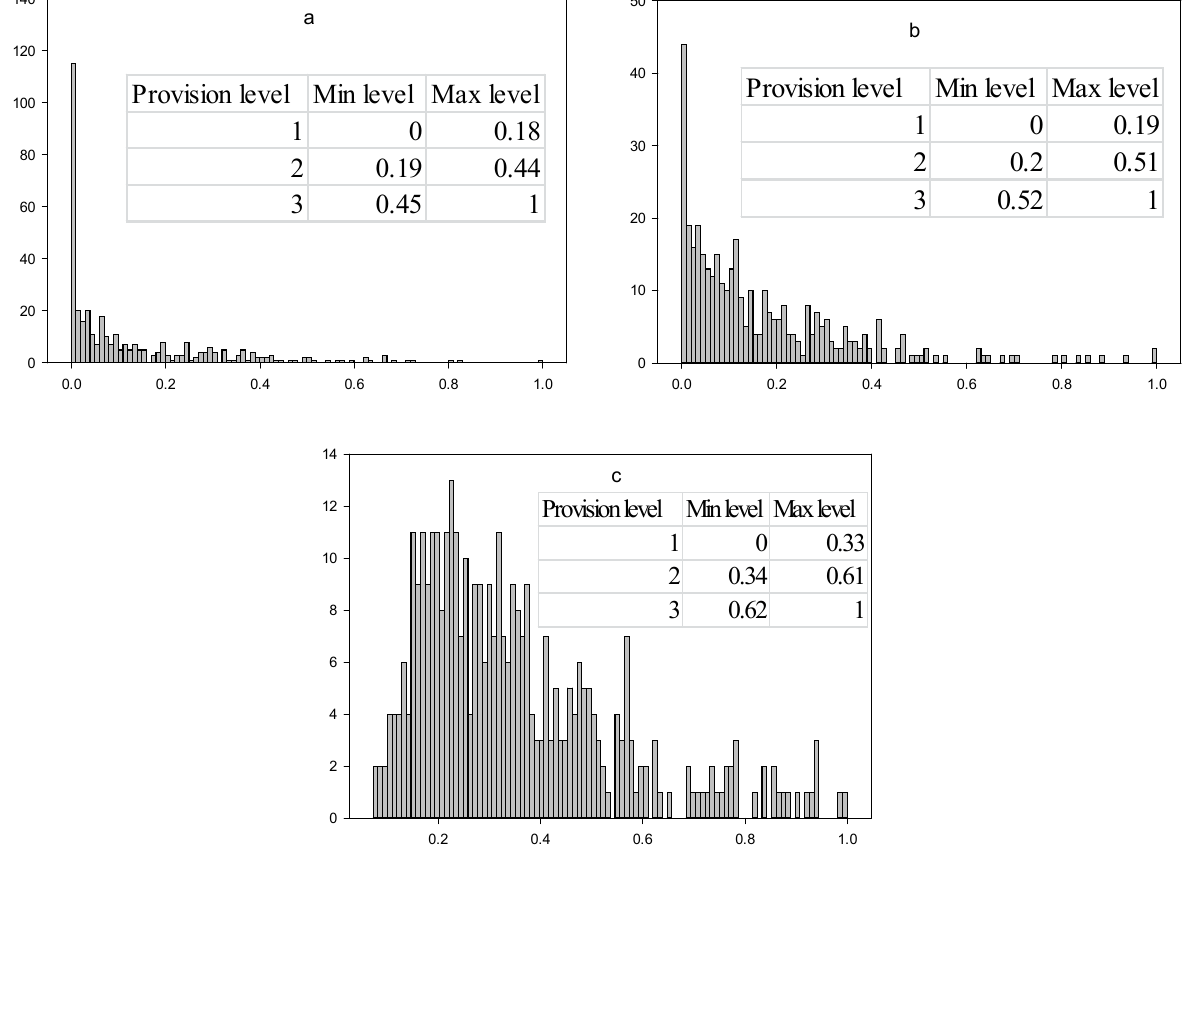
Figure 2. Histograms of the normalized values on a 0–1 scale for net carbon sequestration ( a ), timber volume ( b ), and water yield ( c ) using a 3-class classification scheme generated by the natural breaks algorithm using ARCGIS. Negative values were assumed to be 0. Note that the Y axes are counts and X axes are normalized values. Insert tables indicate